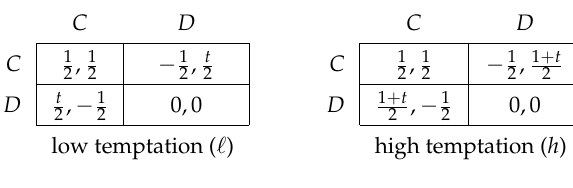
Table 1. The two situations under a binary categorization with threshold t